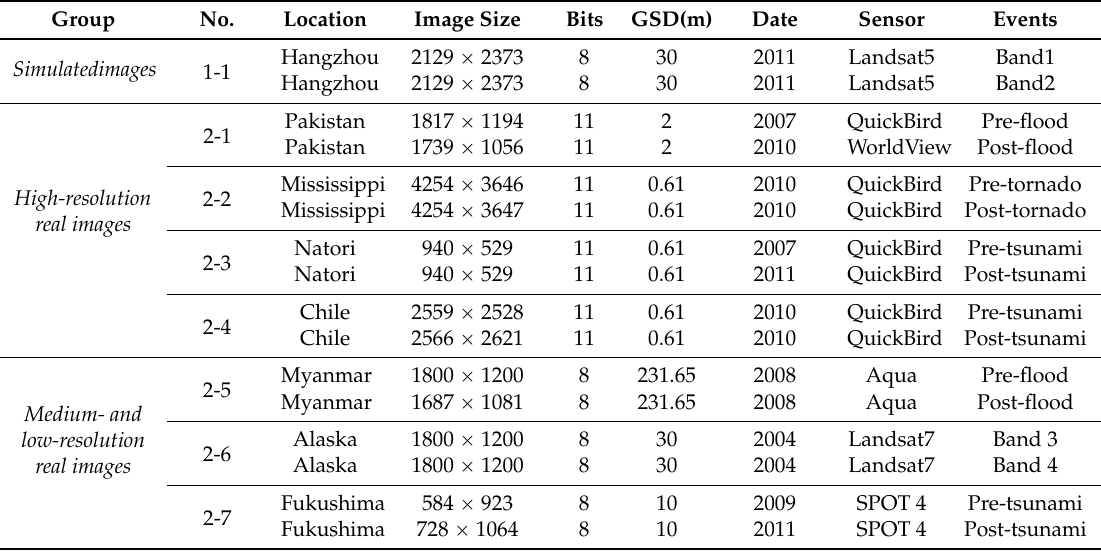
Table 2. The complete information of all experimental satellite image pairs.